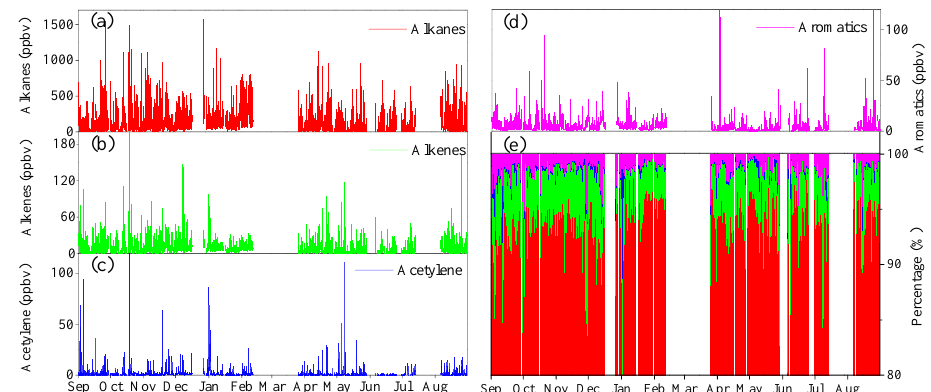
Figure 3. Time series of 2-hourly concentrations (ppbv) for the four VOC categories including alkanes (a) , alkenes (b) , acetylene (c) , aromatics (d) and their fractions (e) during the sampling period.